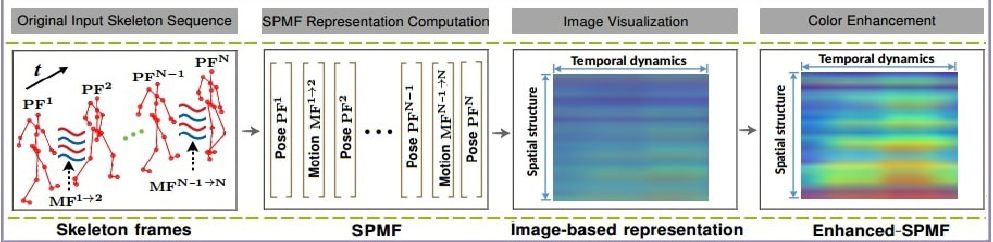
Figure 3. Illustration of the Enhanced-SPMF representation. To build an Enhanced-SPMF map from skeletal data, each skeleton sequence is first encoded as a single RGB image via a skeleton-based representation called SPMF (Skeleton Pose-Motion Feature) [53]. The SPMF is built from Pose Feature vectors (PFs) and Motion Feature vectors (MFs), which are calculated from the 3D coordinates of skeletons. Finally, we use a color enhancement technique [55] to enhance the local textures of the SPMF